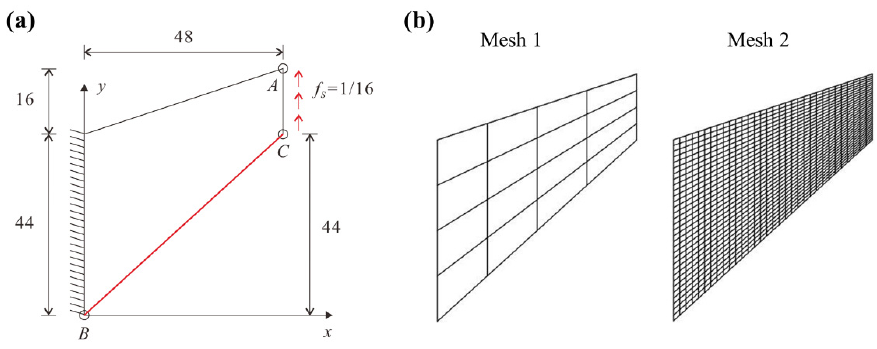
Figure 5. Cook’s skew beam problem: ( a ) Problem description. ( b ) Quadrilateral meshes (Mesh I and II) used. Table 1. Relative errors (%) in the energy norm ( E ) and the vertical displacement ( v ) at the point A in the Cook’s skew beam problem.